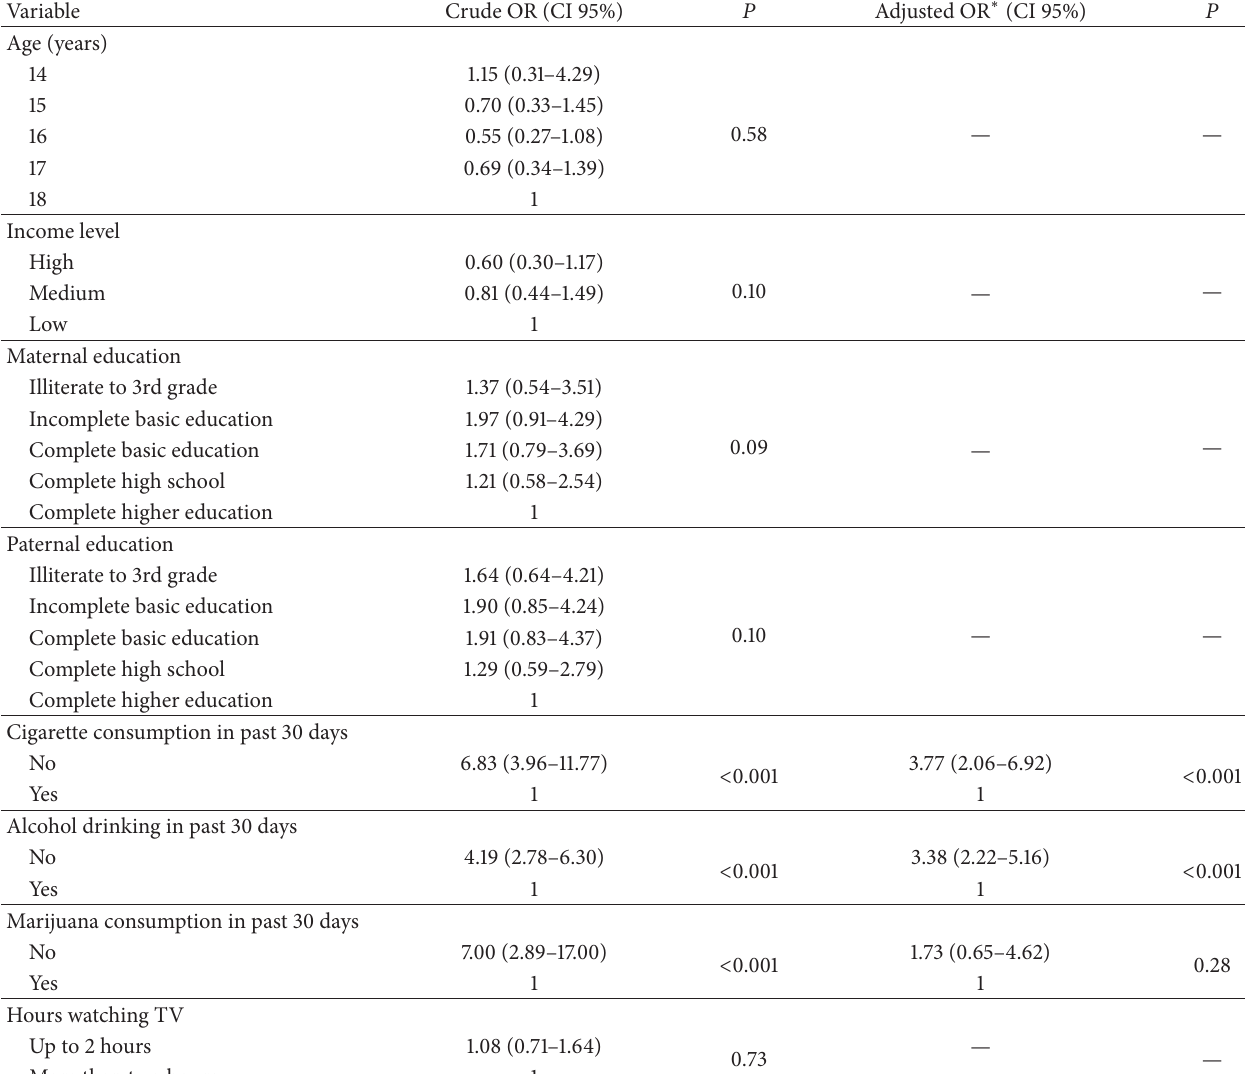
Table 2: Association between violent behavior and associated factors among female adolescents. State of Sergipe,